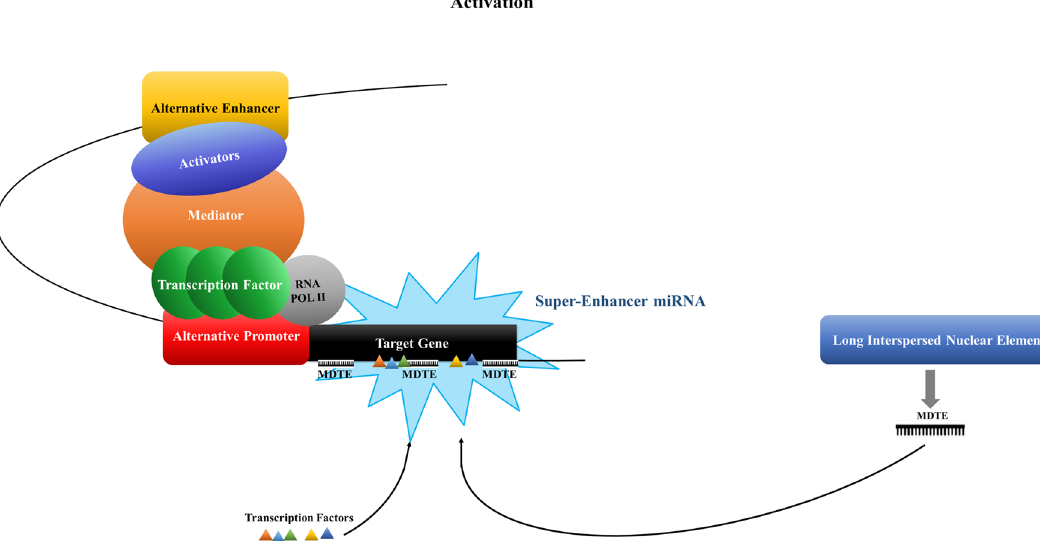
Figure 5. Schematic illustration of overall summarization on enhancer activity of hsa-miRNA-625-5p and NF-κB in 3 ′ UTR of GATAD2B . The theory of the MDTE providing the sequence to TFs and them cooperating to grant super-enhancer miRNA ability to the